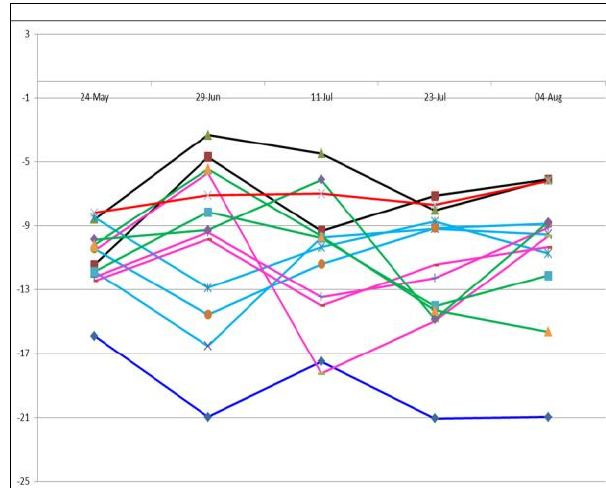
Figure 8: Signatures as obtained from Sentinel-1 multi-temporal dataset 2017, Andhra Pradesh ( Paddy early: sky blue, paddy normal: pink, paddy late: green, water body: dark blue, forest scrub: Red, cotton: black